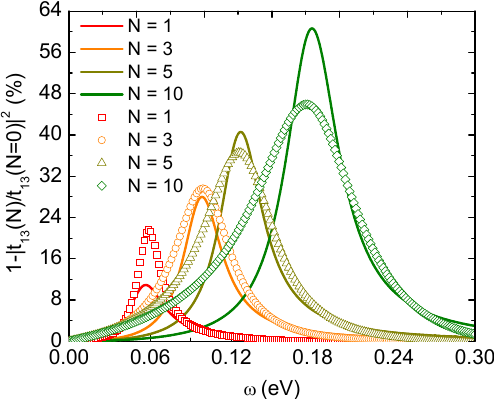
Figure 2. (Color online) Extinction spectra for systems having a graphene-disk array with D = 210 nm, the width of 60 nm, E F = 0.45 eV for the number of graphene layers N = 1, 3, 5, and 10 calculated using the theoretical approach (solid lines) and CST simulations (points).